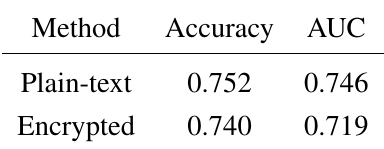
Table 1. Results for METABRIC dataset with 5-fold